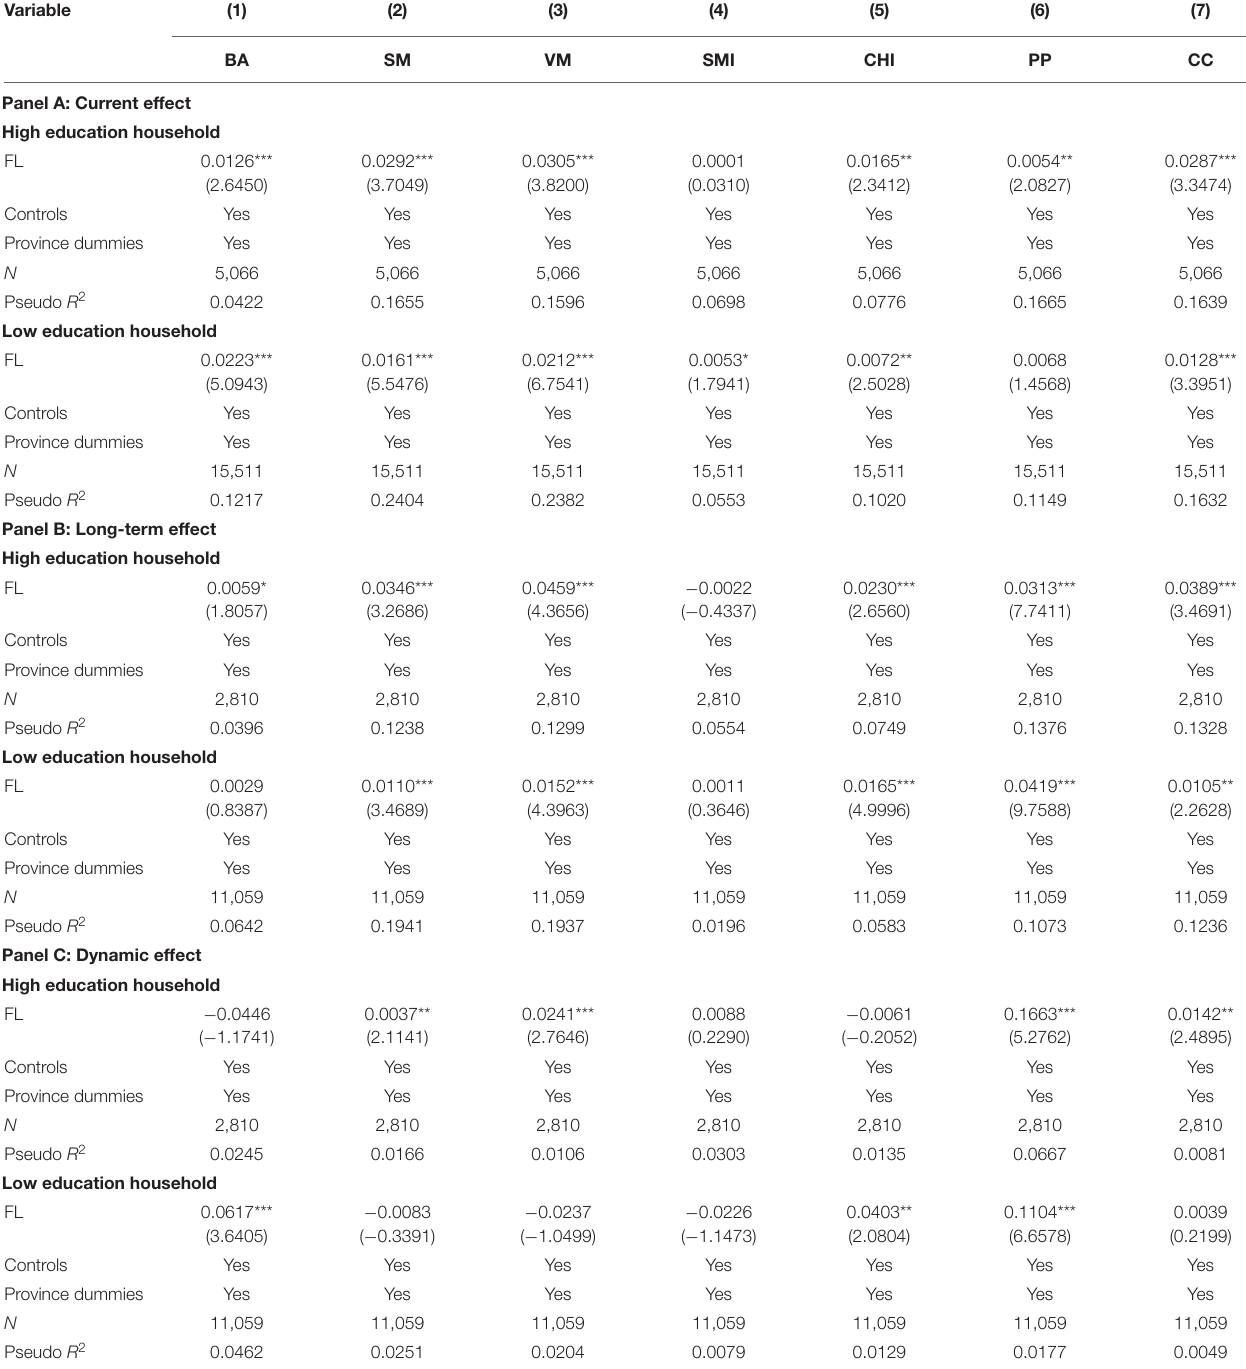
TABLE 17 | Education level heterogeneity